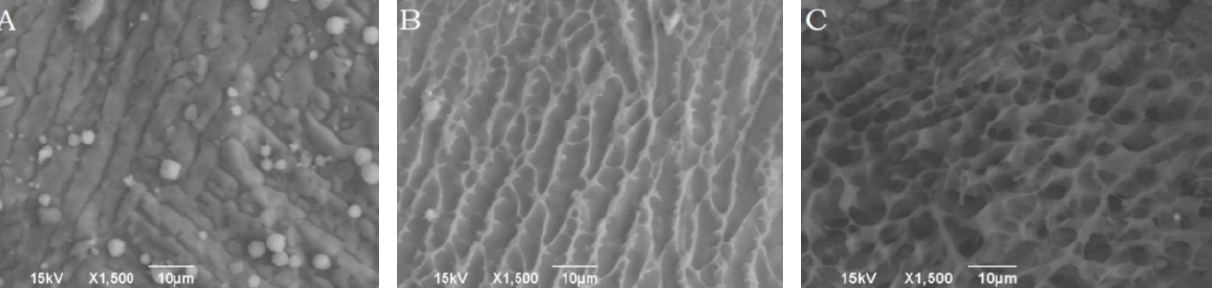
Figure 4. Cryo-SEM images visualizing the morphologies of freshly cut surfaces of the polymeric delivery systems maintained at 25 °C, ( A ): 0 min and ( B ) 5 min after sublimation; and ( C ) at 37 °C, 5 min after sublimation.